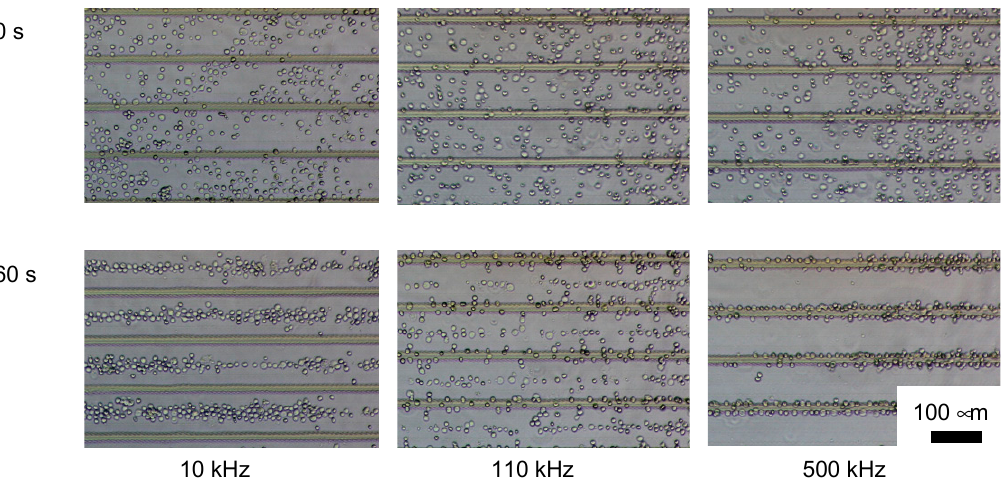
Figure 5. Dielectrophoresis of ES-B3 cells using a parallel line-electrode array before (0 s) and after (60 s) dielectrophoresis.